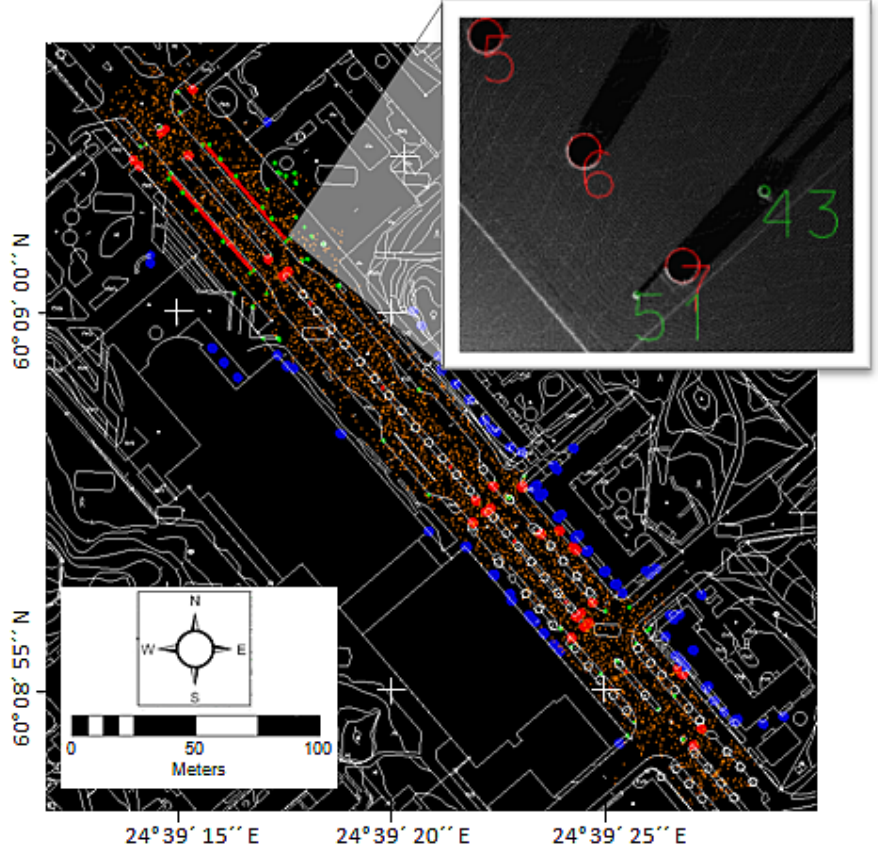
Figure 4. The reference targets: orange points are elevation reference points and blue (targets 5 m above ground), red (large poles) and green (small poles) points are planimetric reference points (the map data provided by the courtesy of the City of Espoo). The small figure in the top right corner shows a detail of the measured poles from close-to-ground laser